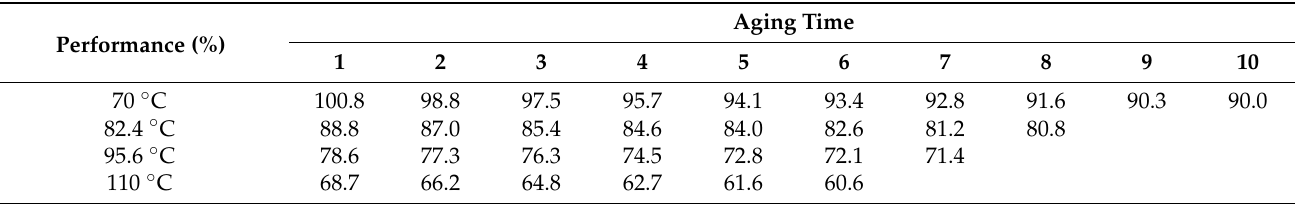
Table 1. Tensile strength retention at different aging temperatures